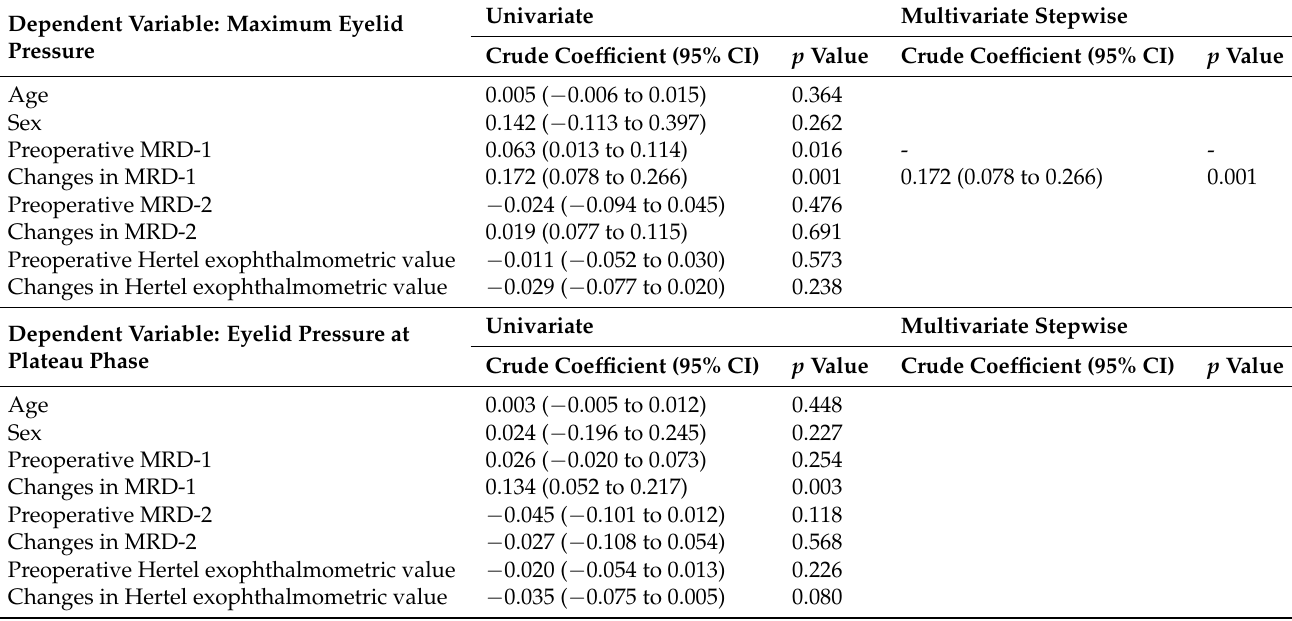
Table 4. Results of univariate and multivariate linear regression